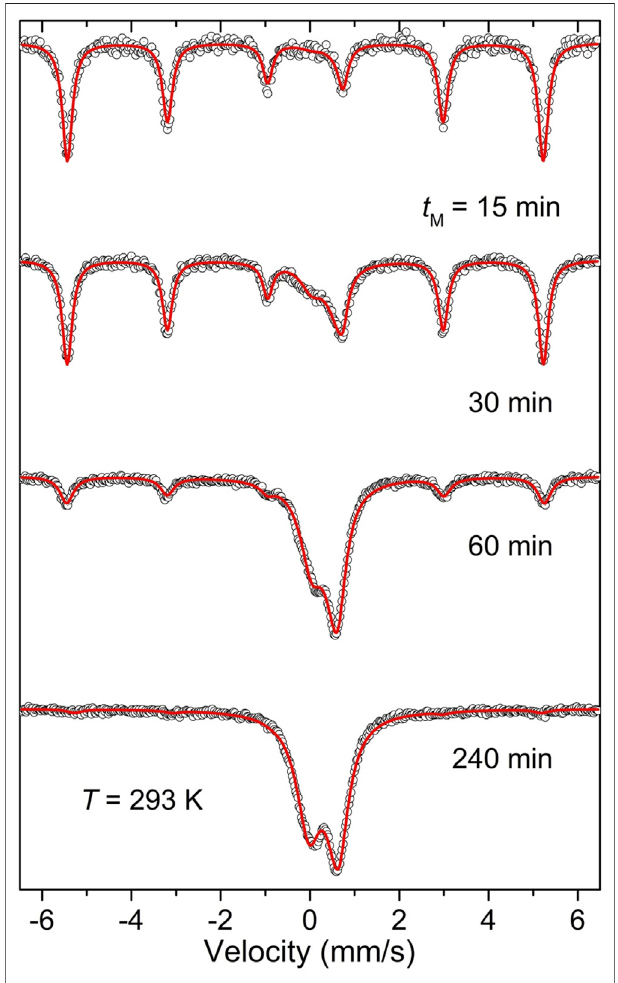
FIGURE 3 | Room-temperature 57 Fe Mössbauer spectra of the 2 SrO + α -Fe + MoO 3 mixture milled for various times ( t M ) up to 240 min.